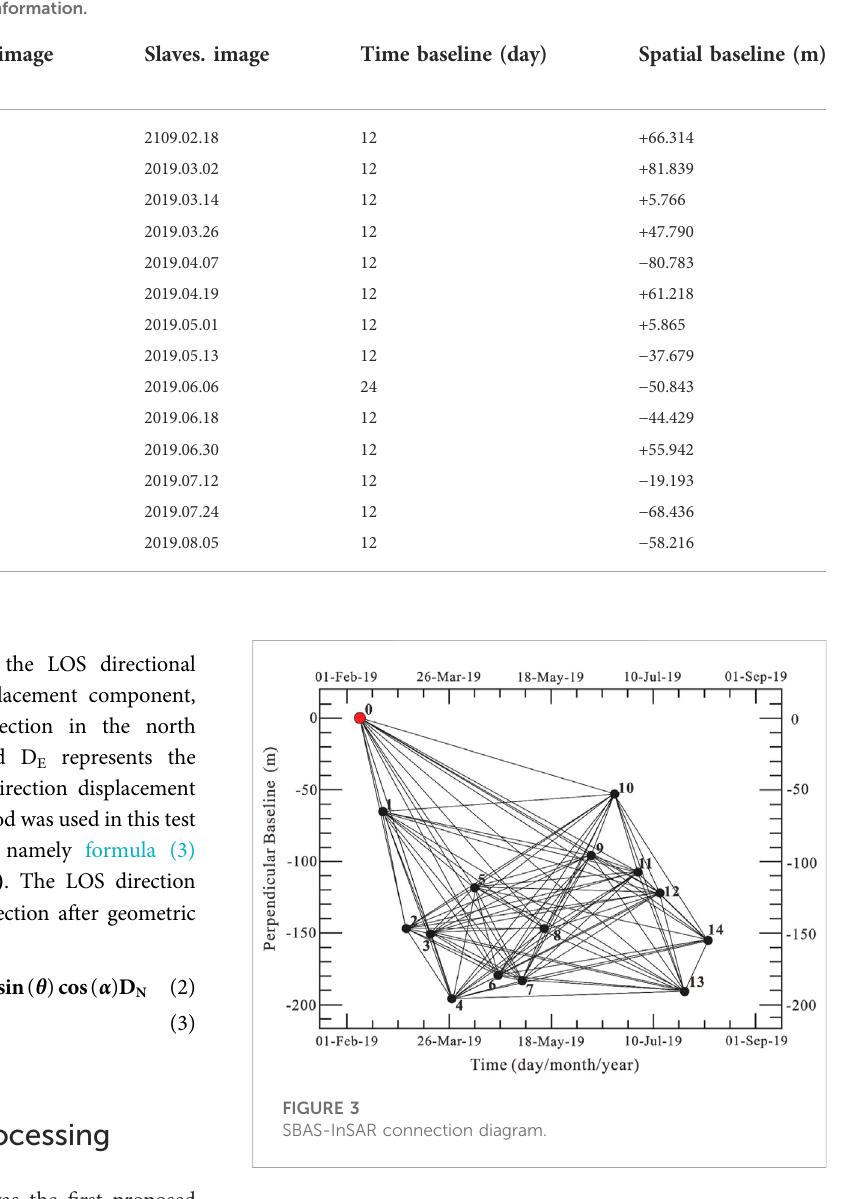
TABLE 2 Differential interferogram data key information.